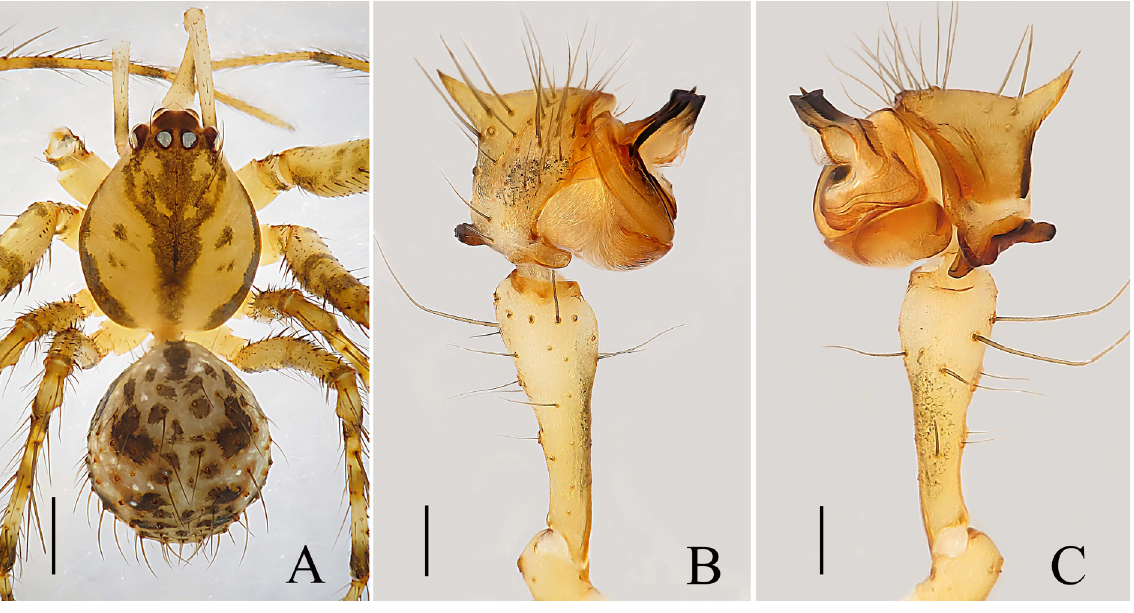
Fig. 1. Mimetus bucerus sp. nov. A – C . Holotype, ♂ (GZ-MIM-2017-005). A . Habitus, dorsal view. B . Palp, prolateral view. C . Palp, retrolateral view. Scale bars: A = 1.0 mm; B–C = 0.1